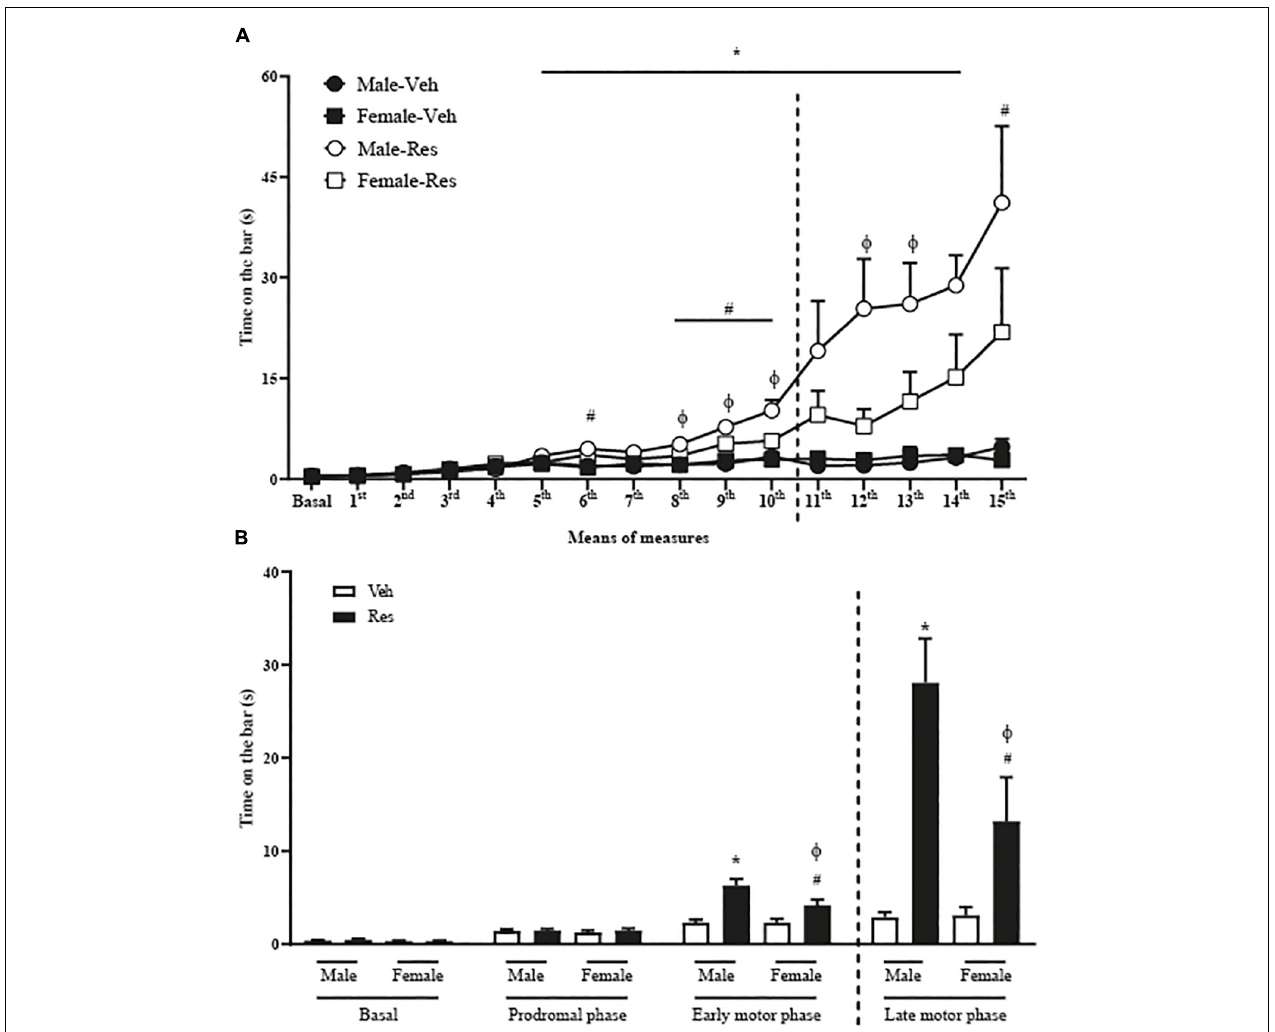
FIGURE 2 | Effects of repeated treatment with 0.1 mg/kg reserpine (Res) or vehicle (Veh) on catalepsy behavior in female and male rats throughout the treatment (A) and grouped in phases (B) basal (without injection of Res or Veh), prodromal (1 ∼ 5 injections), early motor (6 ∼ 10 injections), and late motor (10 ∼ 15 injections). Dashed lines indicate the euthanasia of half the animals. * p < 0.05 comparing Male-Res and Male-Veh, # p < 0.05 comparing Female-Res and Female-Veh and φ p < 0.05 comparing Male-Res and Female-Res (Two-way repeated-measure ANOVA followed by Sidak’s post hoc test). Values were expressed by mean ± SEM. Individual data are displayed in Supplementary Tables 1, 2